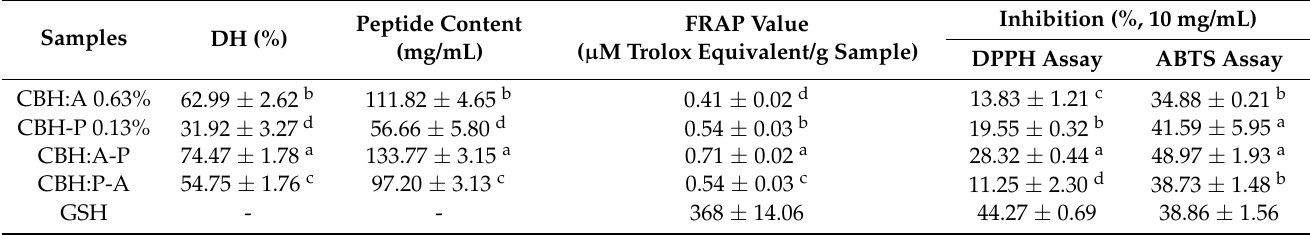
Table 1. Degree of hydrolysis (DH), peptide content, and antioxidant activity of chicken breast hydrolysates (CBH) under various conditions 1,2